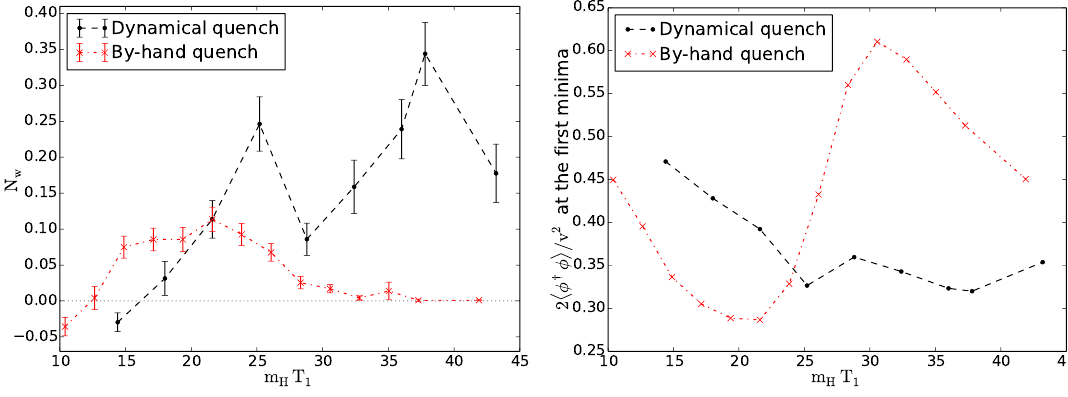
Figure 3 . Left: the (cid:12)nal asymmetry (in N w ) for the dynamical (black) and by-hand (red) sim- ulations. Right: the value of the Higgs (cid:12)eld (squared) at the (cid:12)rst minimum. Note the strong correlation between a low Higgs minimum and a large